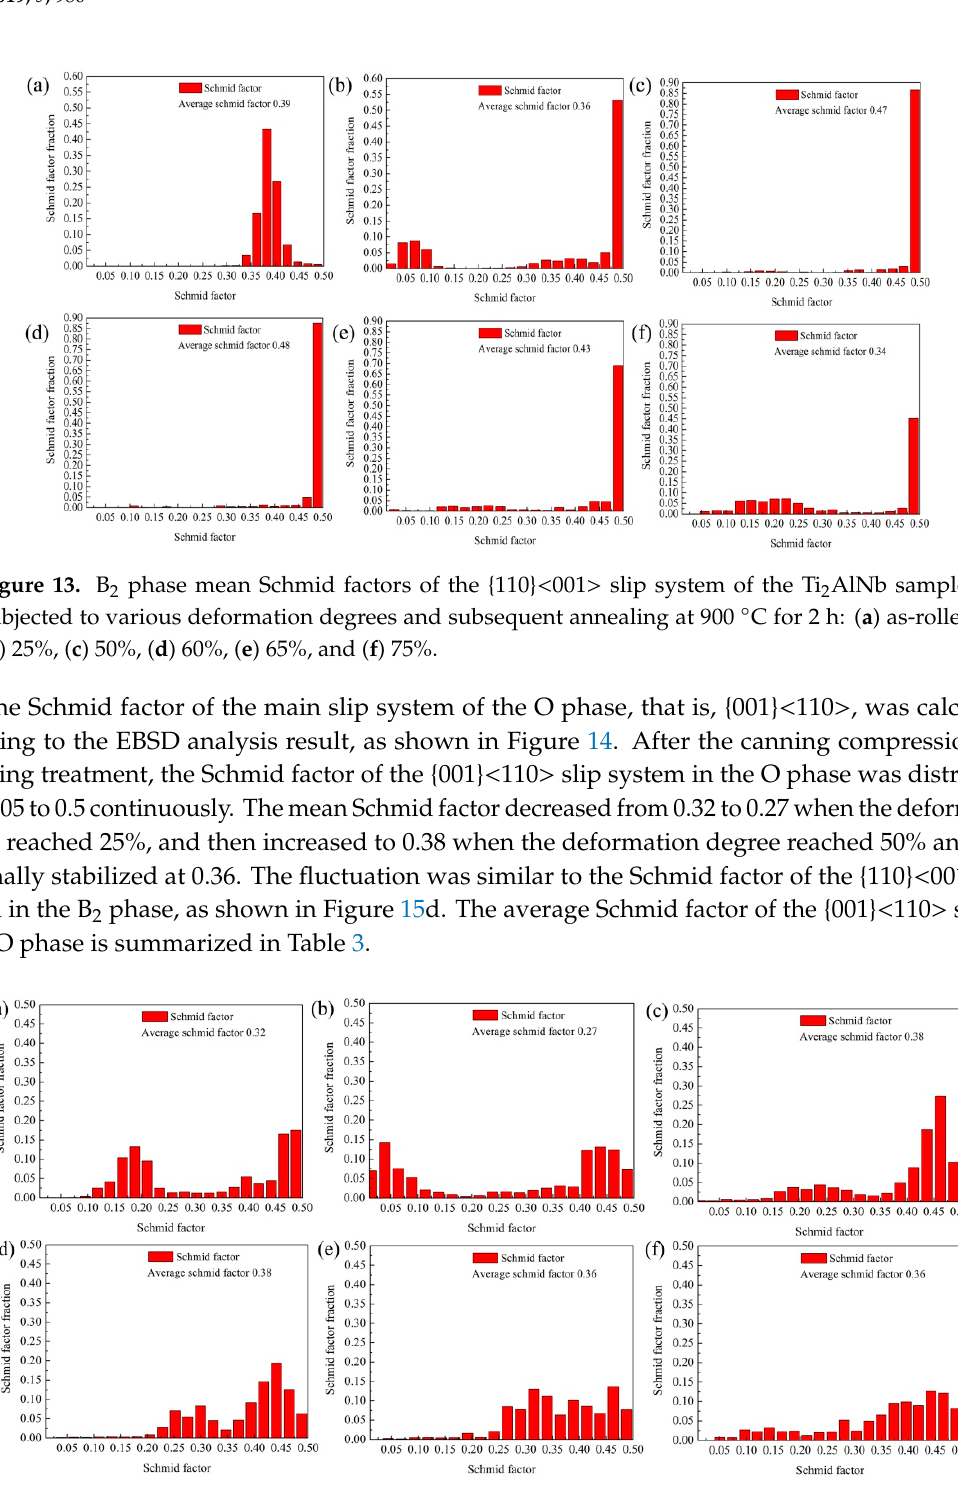
Figure 14. O phase mean Schmid factors of the Ti 2 AlNb samples in {001} < 110 > subjected to various deformation degrees and subsequent annealing at 900 ◦ C for 2 h: ( a ) as-rolled, ( b ) 25%, ( c ) 50%, ( d ) 60%, ( e ) 65%, and ( f ) 75%.